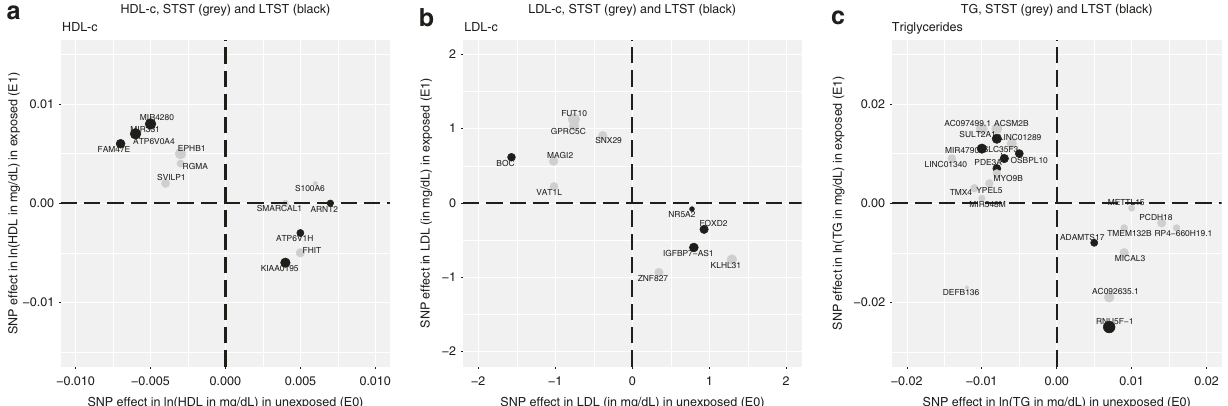
Fig. 4 Comparison of SNP-main effects strati fi ed by exposure. X -axis displays the effect sizes of the novel lead SNPs as observed in the meta-analyses of the unexposed individuals (LTST = '0', STST = '0'). Y -axis displays the effect sizes of the novel lead SNPs as observed in the meta-analyses of the exposed individuals (LTST = '1', STST = '1'). In black are the novel lead SNPs identi fi ed with LTST; in grey are the novel lead SNPs identi fi ed with STST. Sizes of the dots were weighted to the difference observed between exposed and unexposed. Visualisation of the plots was performed using the R package ggplot2 105 . a HDL-c; b LDL-c; c triglycerides